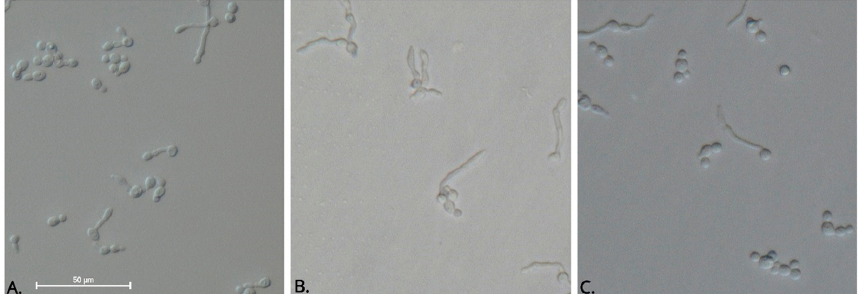
Figure 8. Effect of L1 on C. albicans germ tube formation . Pooled human serum samples were Figure 8. E ff ect of L1 on C. albicans germ tube formation . Pooled human serum samples were inoculated with C. albicans yeast and incubated for 3 h at 37 ◦ C. Morphology was assessed and photographed with a Nikon Eclipse Ni phase-contrast microscope (40 × ) . A . Itraconazole; B . Negative control; C . L1 at 500 µ g mL − 1